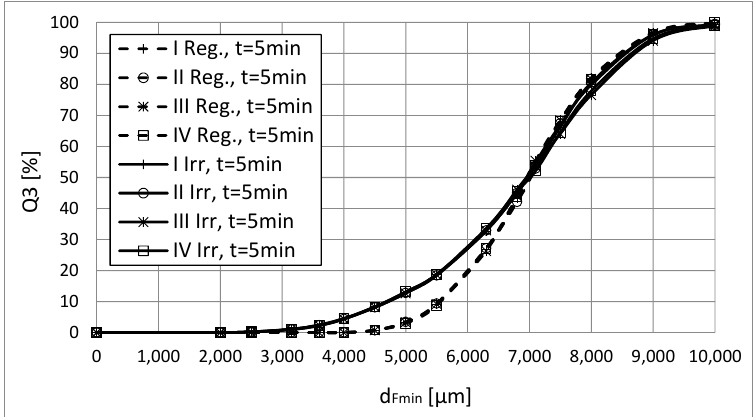
Figure 20. Comparison of particle size distributions of chalcedonite enrichment products for regular and irregular particles.